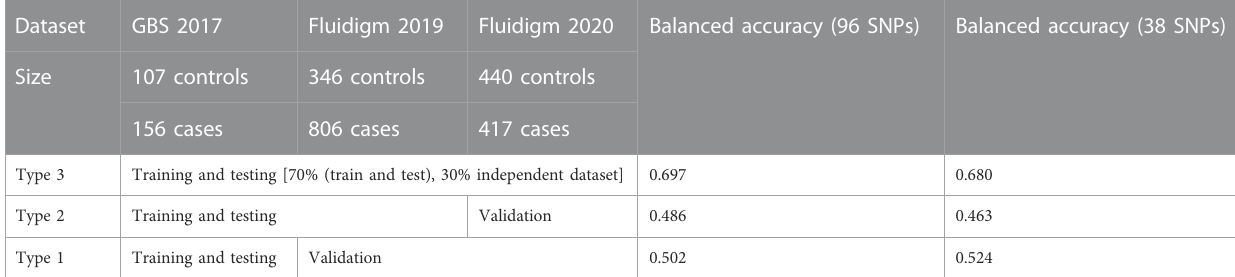
TABLE 1 Selected SNP-assisted machine learning based prediction summary from three different combinations of datasets.